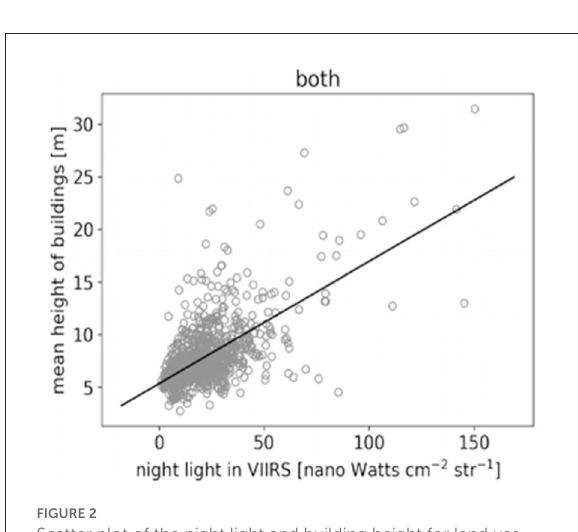
FIGURE2 Scatter plot of the night light and building height for land use ratio of 60% and above.